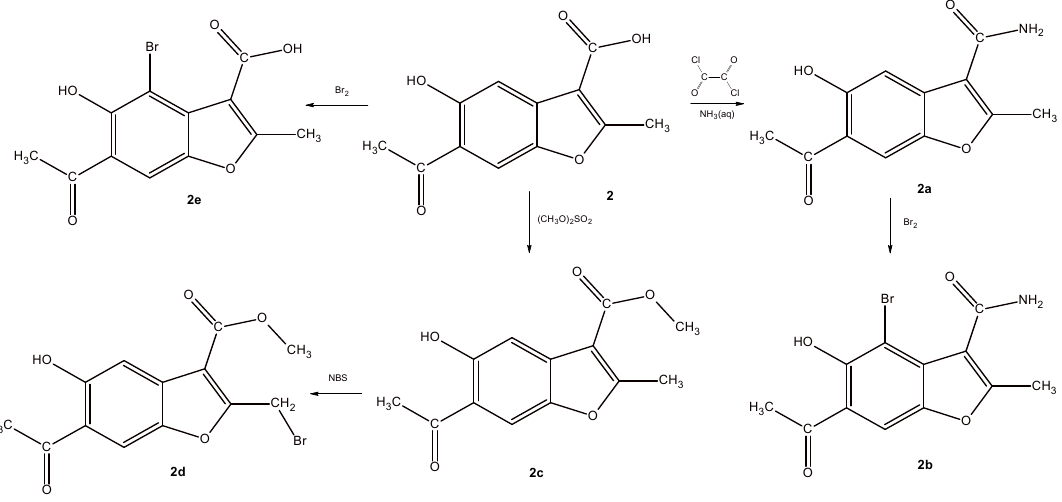
Scheme 2. Synthesis of analogues of compound IX .